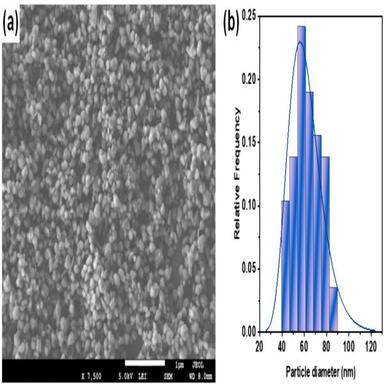
(a) SEM image of NQNs showing nearly spherical particles. (b) Particle size distribution histogram of NQNs.